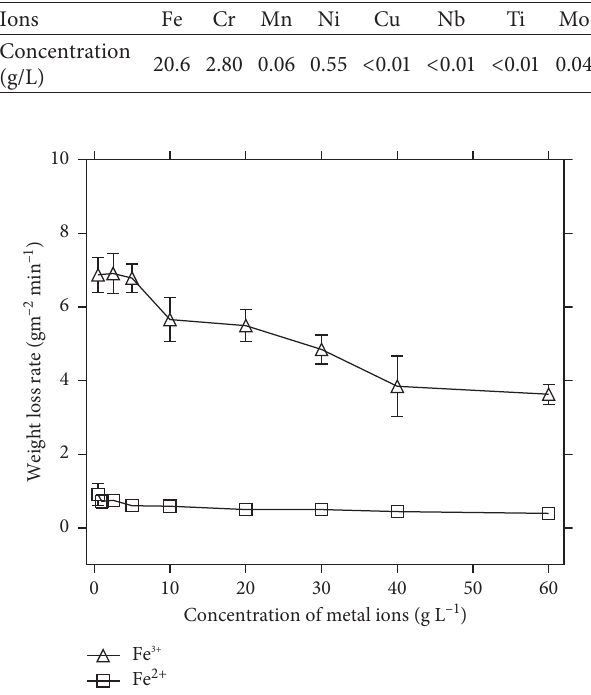
2 SO 4 solutions.